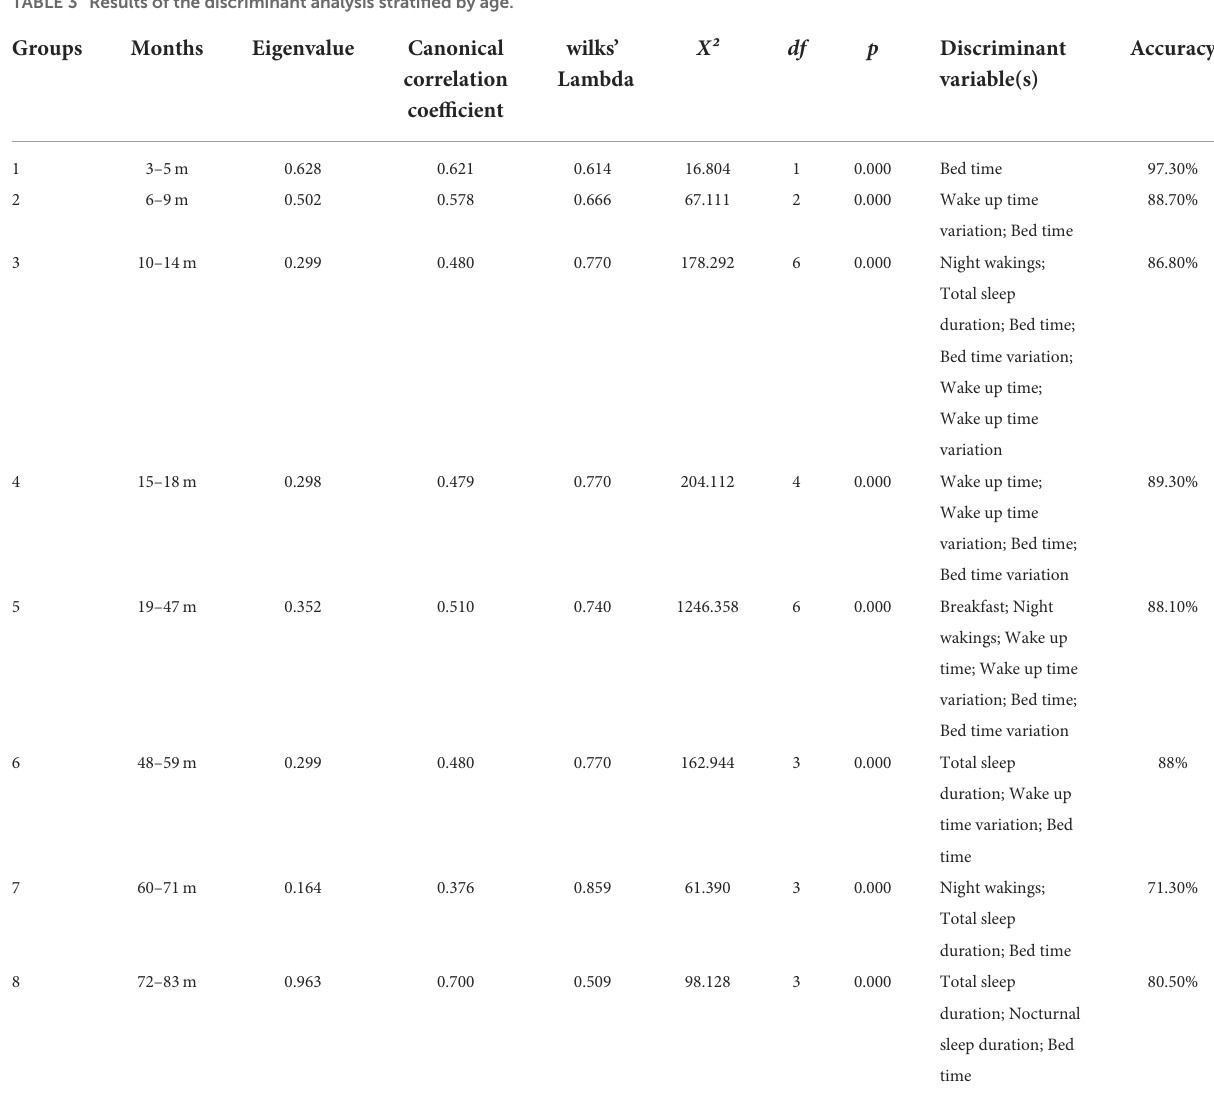
TABLE 3 Results of the discriminant analysis stratified by